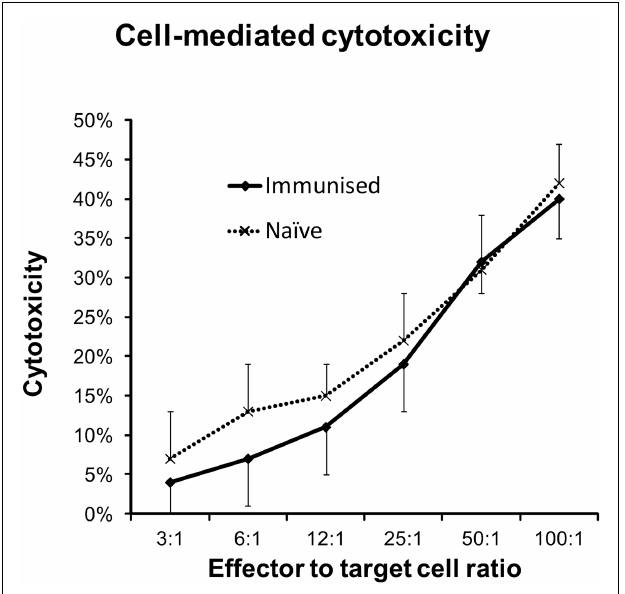
FIGURE 6 | Splenocytes from naïve and immunized C57BL/6 mice were evaluated for cytotoxic responses against DFTD cells . Immunized mice were given IP injections on days 0 and 14 and splenocytes harvested on day 21. DFTD target cells were labeled with CFSE and dead cells identified with PI staining. Flow cytometry was used to calculate cell mediated cytotoxicity as a percentage of CFSE labeled DFTD target cells. Splenocytes from naïve ( n = 4) or immunized ( n = 5) mice and DFTD target cells were incubated for 18h in vitro at 37°C with 5% CO 2 . Results represent the mean and standard deviation of the combined cytotoxicities of all mice with four technical replicates for each mouse.